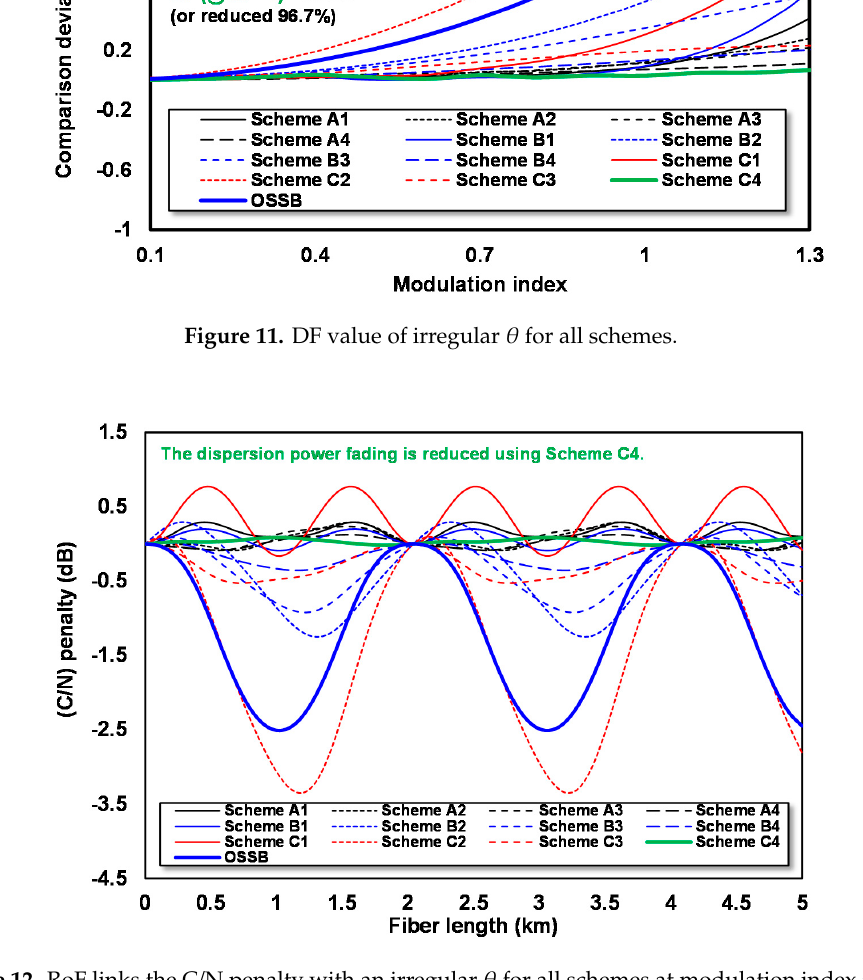
Figure 11. DF value of irregular θ for all schemes.